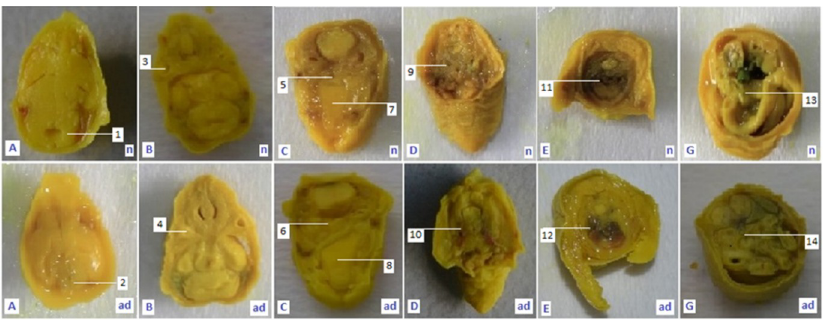
Fig 3. Results of soft tissue examination (see also Fig 1) using the freehand razor blade technique through eight points of fetus body on gestation day (GD) 18. Description, sagittal section trough: A: Brain; B: Eye; C: Oral cavity and digestive tract; D: Esophagus and throat; E: Spine, lungs and heart; G: Small intestine and colon; n: normal anatomy; ad: defective anatomy; 1: normal hind brain; 2: small hind brain; 3: normal len vesicle; 4: small len vesicle; 5: normal respiratory tract; 6: narrow respiratory tract; 7: normal palate; 8: wavy palate; 9: normal throat channel; 10: narrow throat channel; 11: normal trachea; 12: narrow trachea; 13: normal small intestine; 14: narrow small